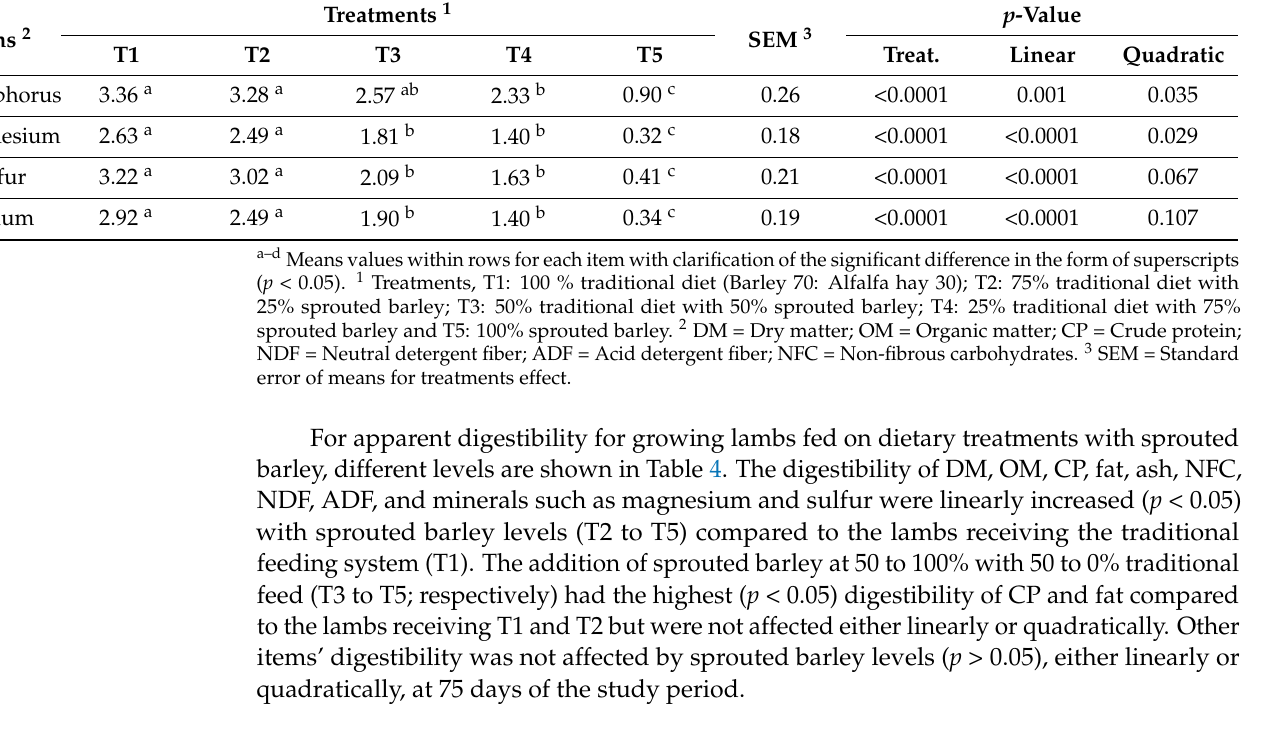
Table 4. Apparent digestibility (%) for growing lambs fed on dietary treatments with different levels of sprouted barley at 75